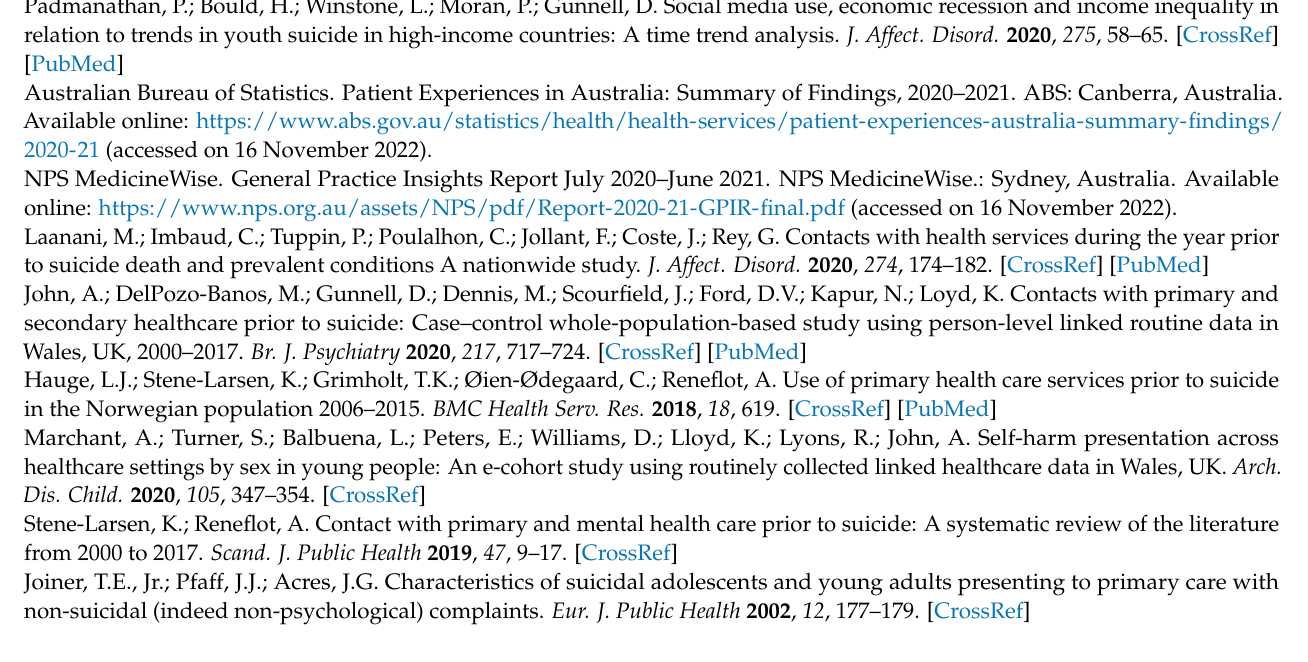
Supplementary Materials: The following supporting information can be downloaded at https: Table S2: Table detailing study qualitative assessments; S3: An Excel file listing data items by study. Author Contributions: D.O. and M.N. developed the study protocol with D.M. providing feedback. DO developed the search strategy and conducted the searches. D.O. and K.D.B. reviewed and agreed on studies for inclusion with M.N. providing input to resolve differences. D.O. developed the data extraction forms with K.D.B. providing feedback. D.O. and K.D.B. completed the data extraction, quality assessment, and thematic analyses. All authors contributed to the development of the selection criteria, the risk of bias assessment strategy, and data extraction criteria. D.O. drafted the manuscript. All authors read, provided feedback, and approved the final manuscript. All authors have read and agreed to the published version of the